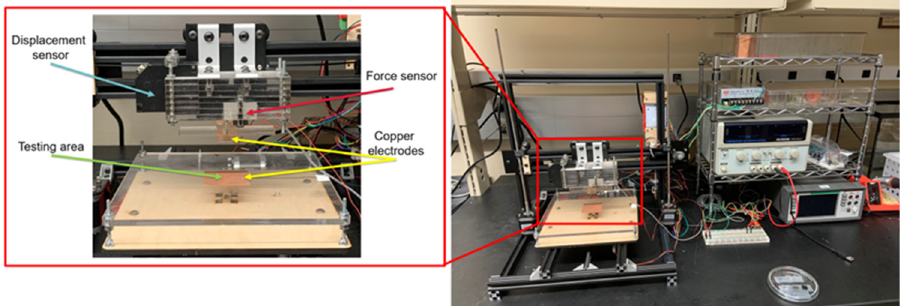
Figure 4. A detailed view of the force application mechanism with associated equipment for mech- anoelectrical testing ( right ) including magnified region of soft polymeric sensing region ( left ).